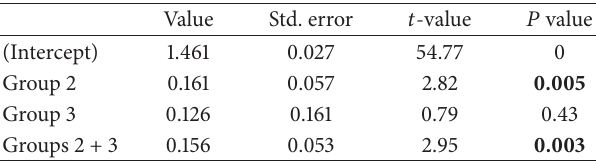
Table 6: Correlation of average IL28B serum levels with different outcomes of HCV infection.